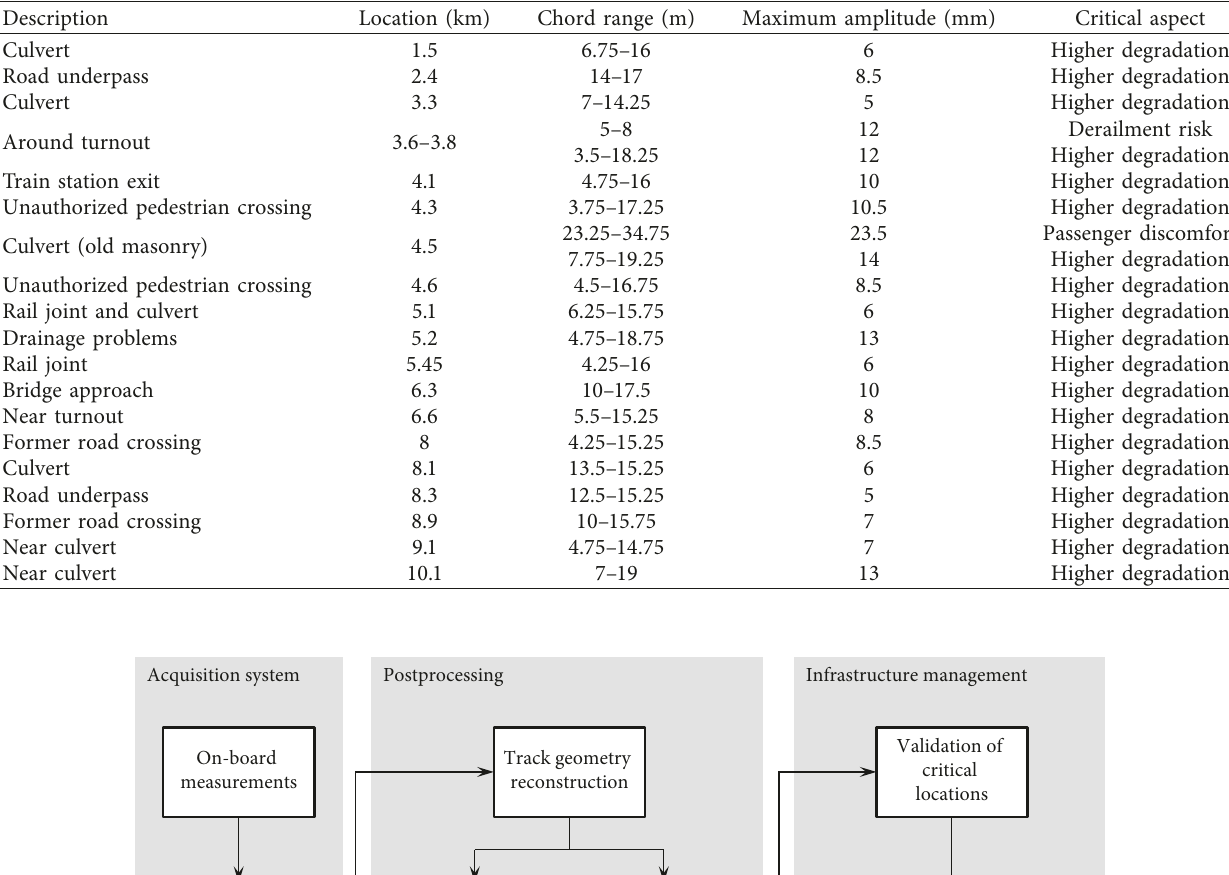
Table 1: Track discontinuities evidencing poor performance.